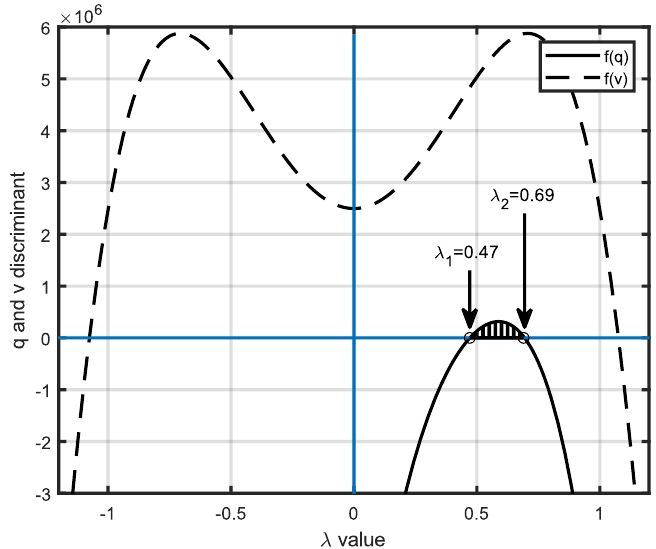
Figure 4. Variations of q and v versus λ for the planar manipulator.